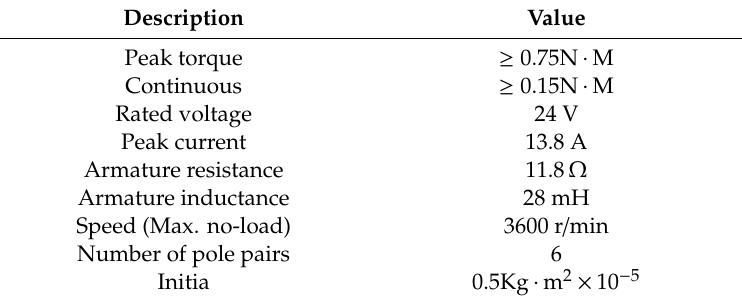
Table 1. Parameters of permanent magnet synchronous motor